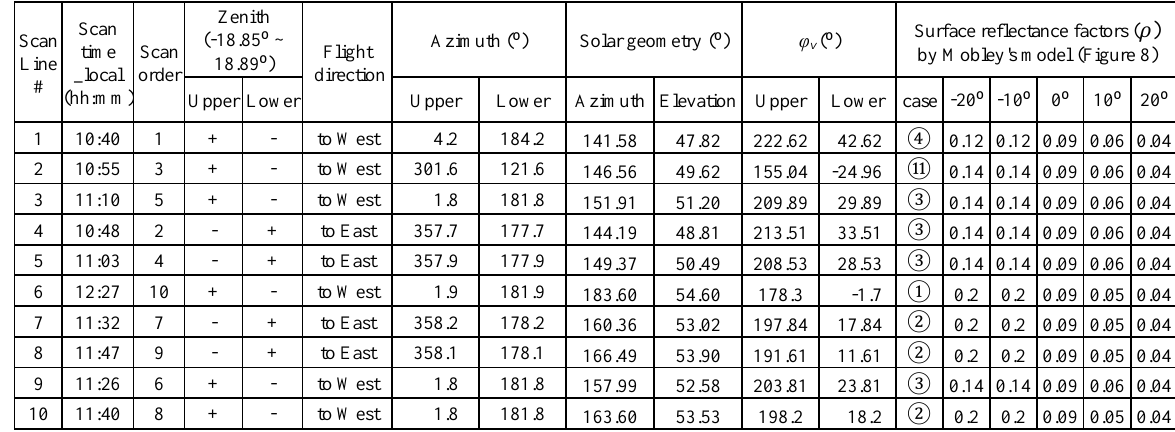
Table 2 . Information regarding hyperspectral image